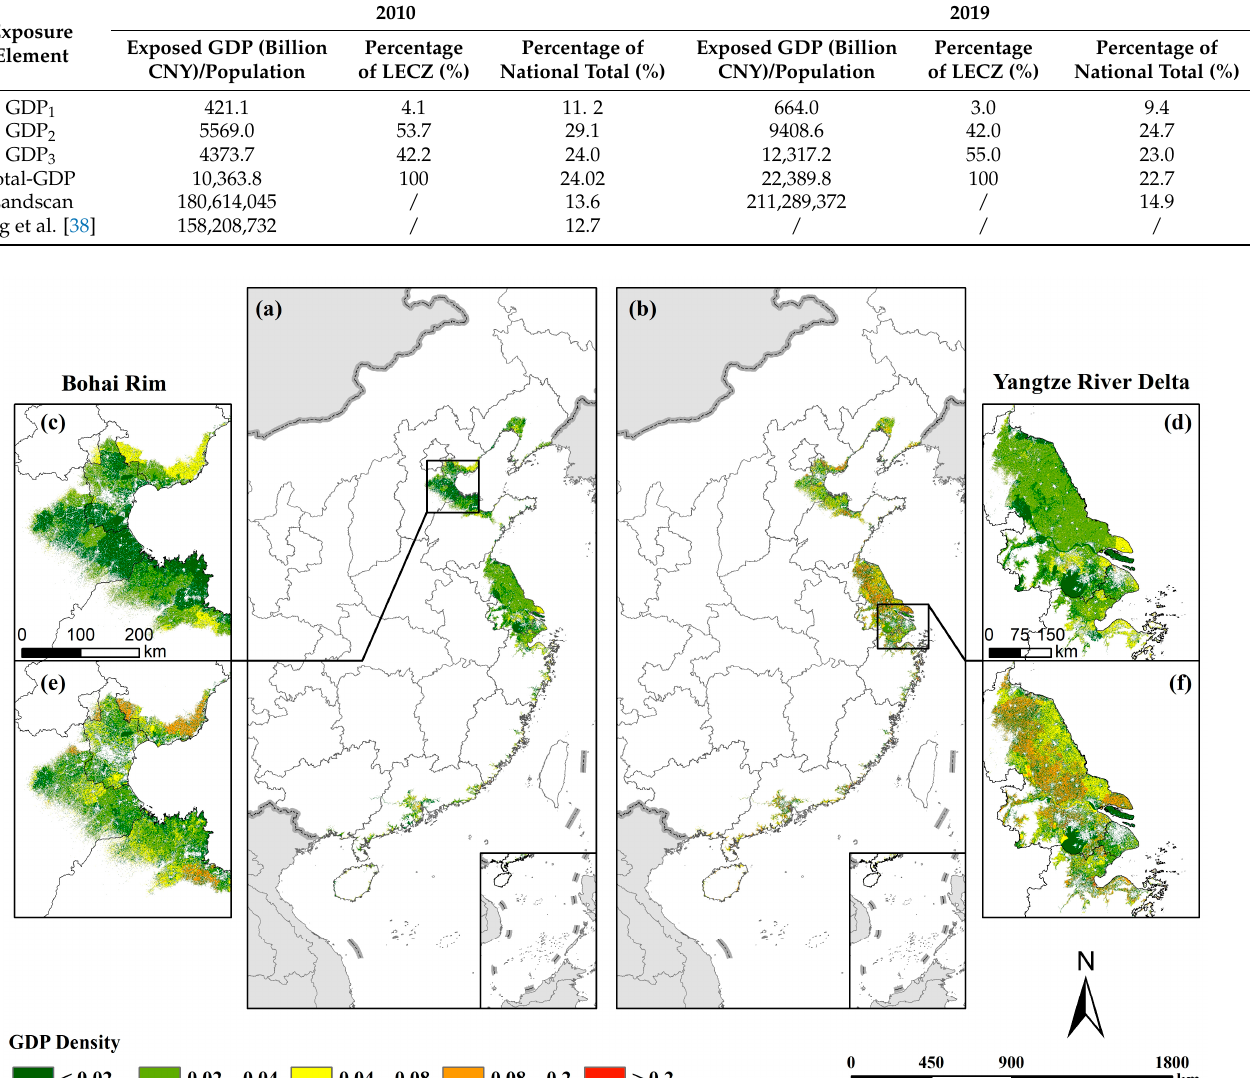
Table 3. GDP Exposure of Different Sectors and the Proportion of LECZ and Corresponding Sector.